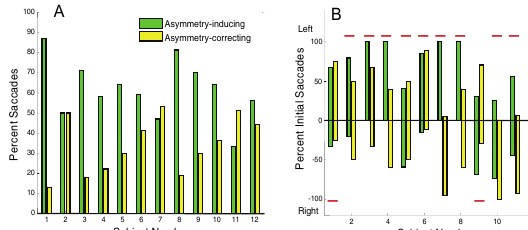
Figure 6 A) The percentage of initial saccades that produce symmetry errors (darker green bars) and the percentage of those that correct symmetry errors (lighter yellow bars). B) Initial direction in percent of error producing (green bars) and error correcting (yellow bars) initial saccades. Percentages are with respect to number of saccades of each type in each direction, not the overall number of initial saccades. The red bars indicate the direction that is toward the preferred (or dominant) eye. (All but three subjects had a preference for the right eye so that a leftward movement would bring that eye closest to the target.)